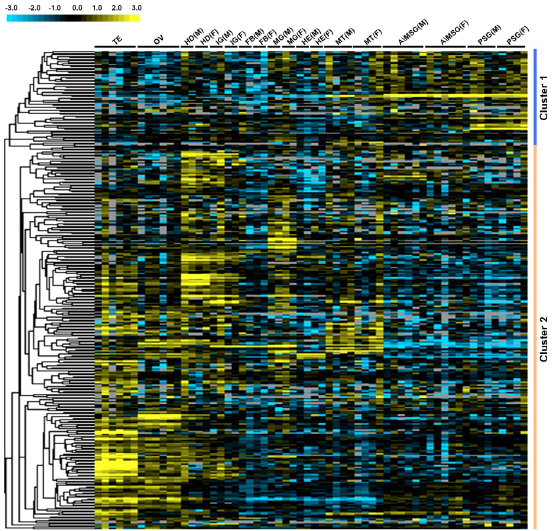
Fig 5. Microarray expression profiling of TFs in multiple tissues of the silkworm. Tissue expression microarray data were obtained from 5L3D silkworm larvae. The expression array figures were constructed by applying the Cluster 3.0 tool and visualized in TreeView. Clusters 1 and 2 are indicated by different colors. The tissues include testis (TE), ovary (OV), head (HD), integument (IG), fat body (FB), midgut (MG), hemocyte (HE), Malpighian tubule (MT), A/ MSG (a mixture of ASG and MSG), and PSG. M, male; F, female.